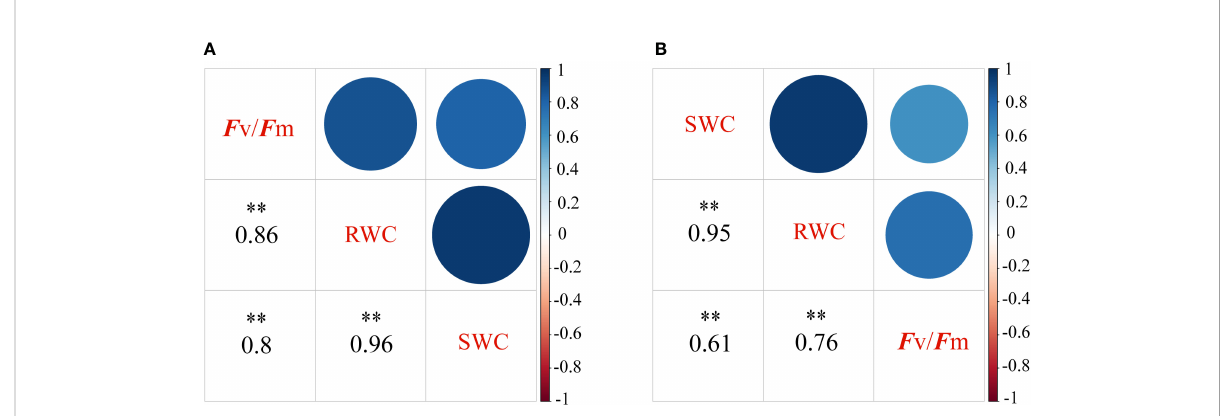
FIGURE 4 Spearman correlation coef fi cients matrix and the corresponding 95% con fi dential levels between F v /F m and the water contents in the roots and leaves. Under normal conditions (A) and under drought stress (B) , respectively. The signi fi cance level of correlations is indicated as follows: **P< 0.01. F v /F m , the maximum photochemical quantum yield; RWC, Root water contents; LWC, leaf water